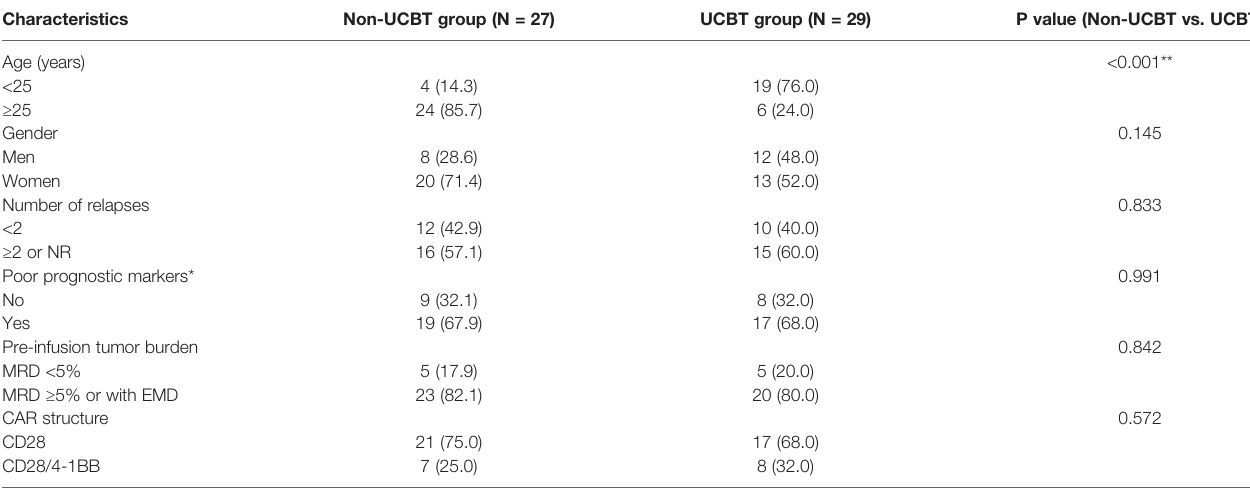
TABLE 3 | Patient characteristics among the two groups.